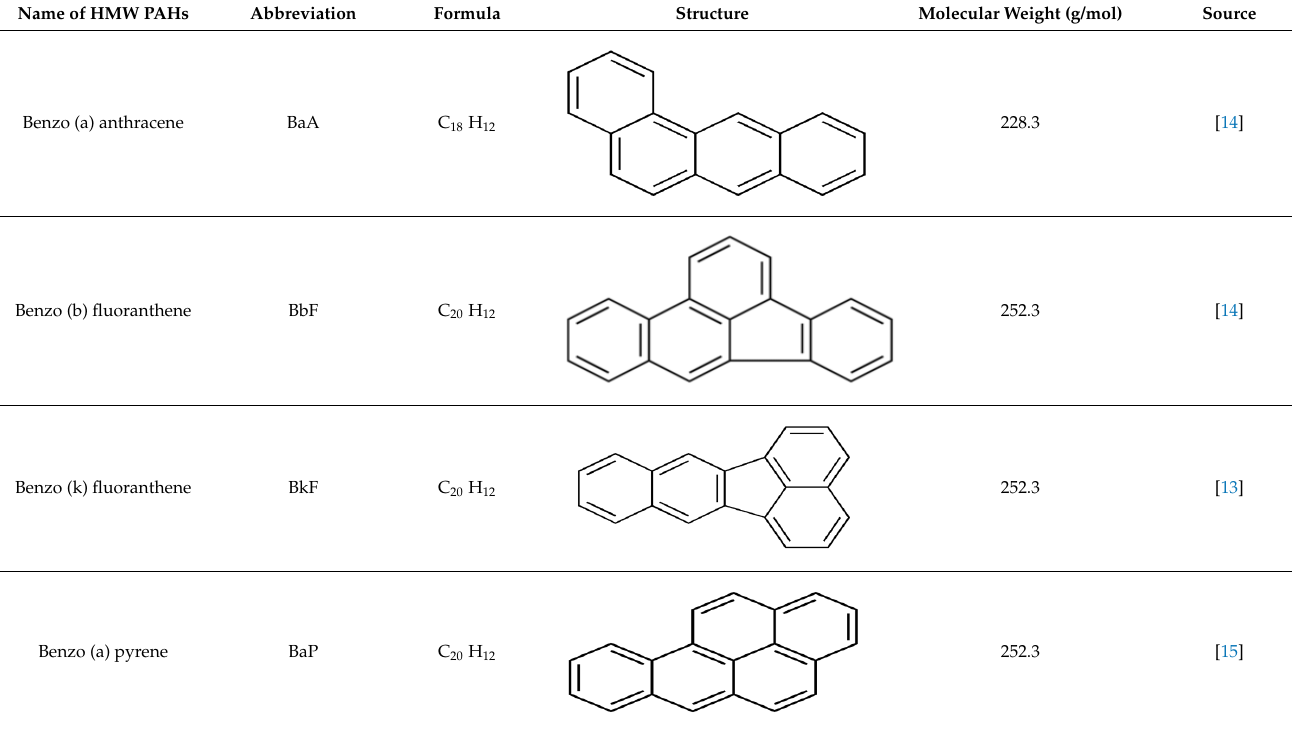
Table 2. Types of HMW polycyclic aromatics hydrocarbons and their molecular structure.